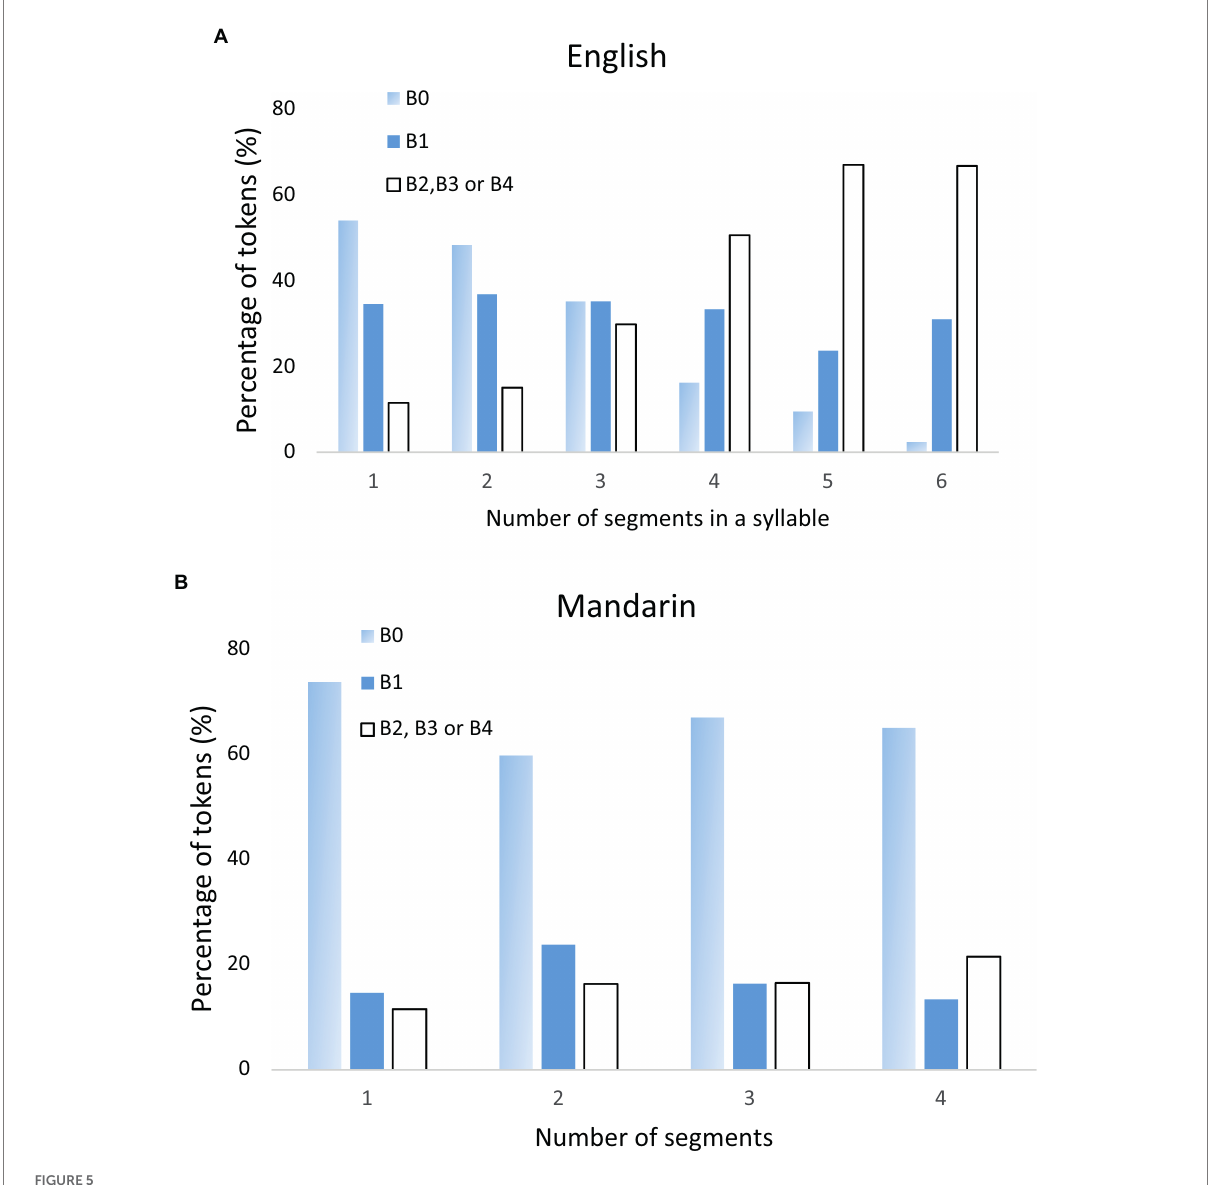
FIGURE 5 Histograms of distribution (% of tokens) of syllables of different sizes before different levels of boundaries ( x -axis) in English (A) and Mandarin (B)